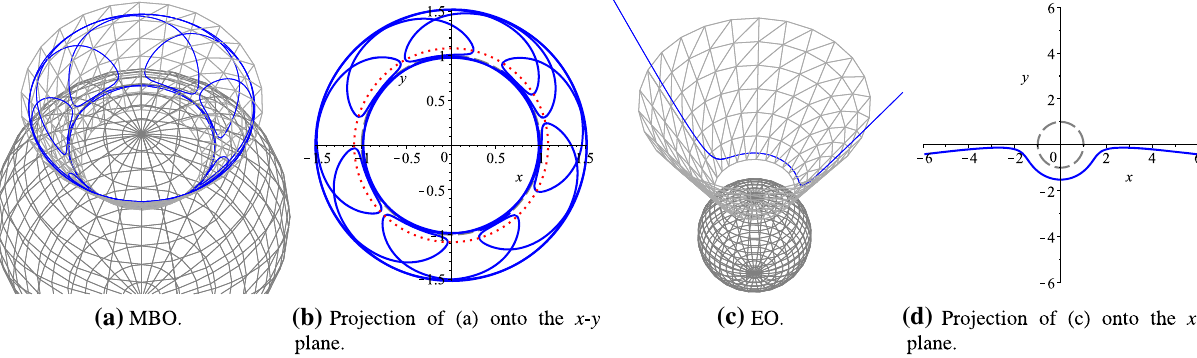
Fig. 8 MBO and EO for parameters K = 12 , L = 8 , δ = 0 , l = 1 , J = 4, and energy E = 0 . 6672265. The trajectory is confined to an area above θ = π/ 2. In b and d the dotted curves denote the turning points of the φ motion. The spheres and dashed circles show the horizon at R = 1